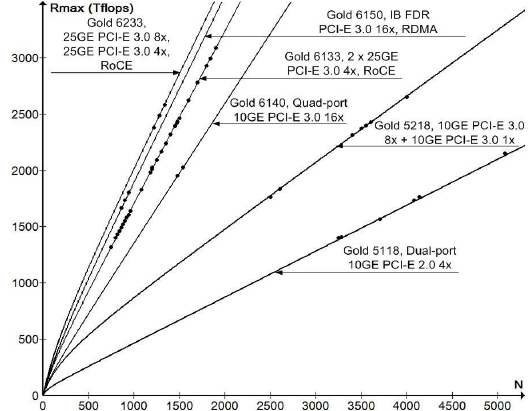
Figure 4. Examples of dependence graphs R̂ max (N) for CPU Intel Xeon Gold (June 2021 TOP500). Table 1. Results of calculations of R̂ max and ε according to the June 2021 TOP500. Rank RDMA